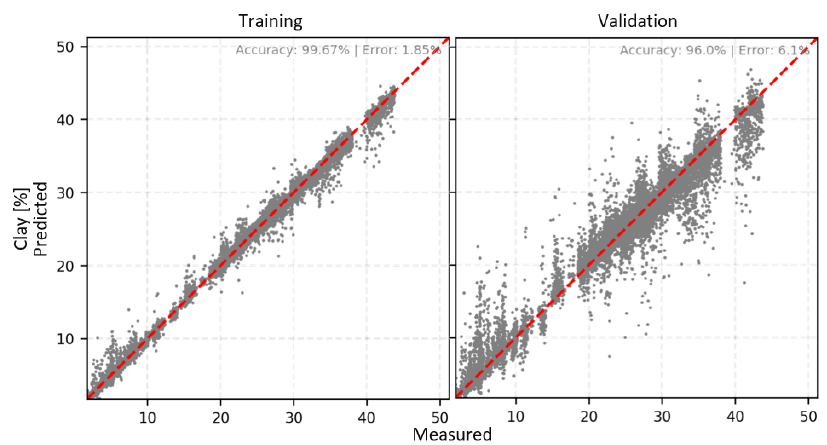
Figure 10. Predicted vs. measured (variance introduced pixel values) clay content for the training and validation data. The red broken line represents the 1:1 line.